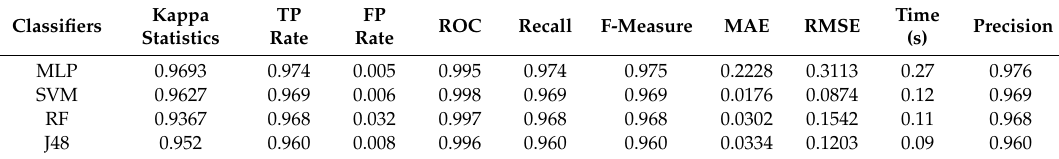
Table 4. The overall classification accuracy table of employed ML classifiers on the liver cancer CT-scan